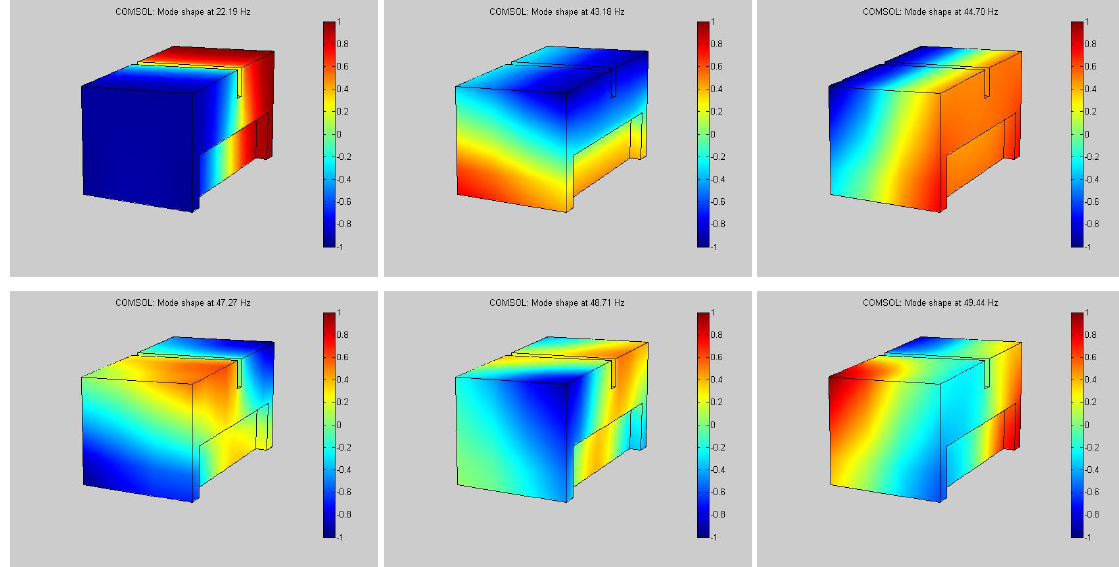
Fig. 4. COMSOL: 6 modes between 20 Hz and 50 Hz.